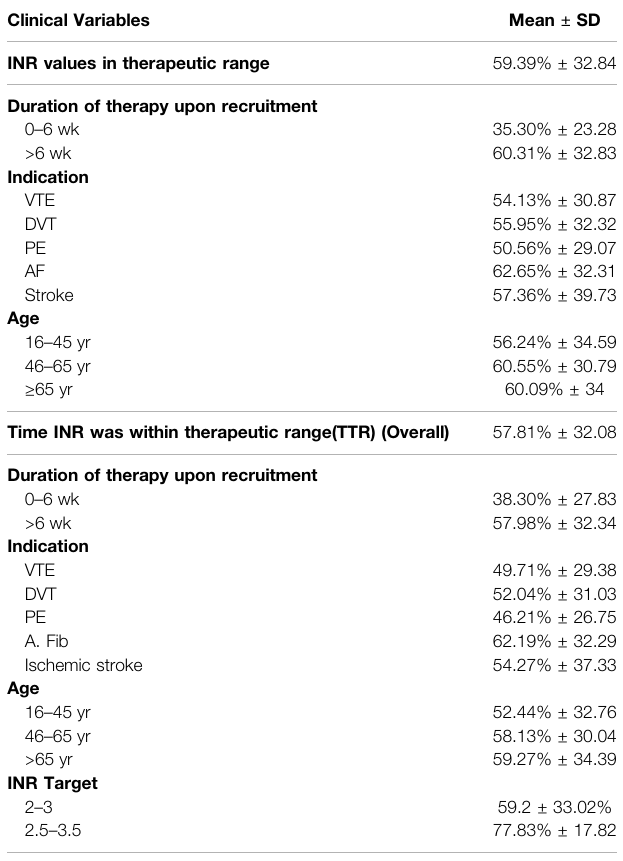
TABLE 3 | Percentage of patients with good, intermediate, and poor control.